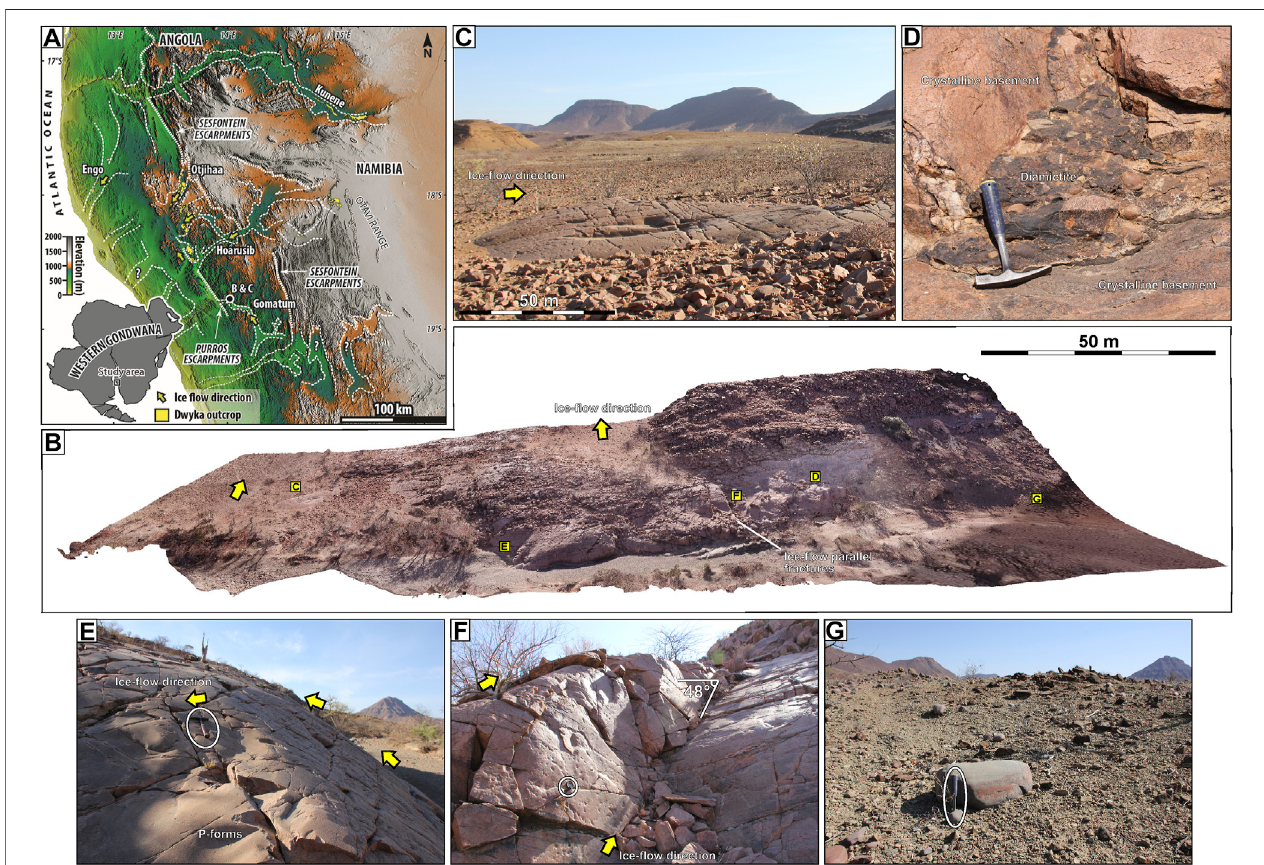
FIGURE6| Digitaloutcrop modelofalateCarboniferousrochemoutonéeinNamibia, supplementedby fi eldphotographs. Inthisregion,Martin andSchalk(1959) were the fi rst to document bedrock grooves and polished, striated crystalline basement carved during the Late Palaeozoic Ice Age. (A) Map of the fjord network of northern Namibia, showing location of the example and palaeo-ice fl ow directions. (B) Three dimensional model produced from photographs taken by a DJI Mavic Pro UAVinSeptember2019.Theimageshowsalarge,highreliefbedrockfeaturewithaverysteepstossslope.Thelocationofotherfeaturesinthis fi gureareindicated by the lettering, together with the Late Carboniferous ice fl ow direction. (C) Small roches moutonée which allows palaeo-ice fl ow orientation to be con fi dently indicated. (D) Typical relationship between crystalline basement and (fragmentary) diamictite. The latter is plastered onto high angle slopes yet is remarkably well preserved. (E) P-forms developed on the steep stoss slope (ice fl ow direction indicated). (F) Glacial polish developed on a steep slope. (G) In present lower lying areas, large facetted, striated boulders weather out from diamictite.